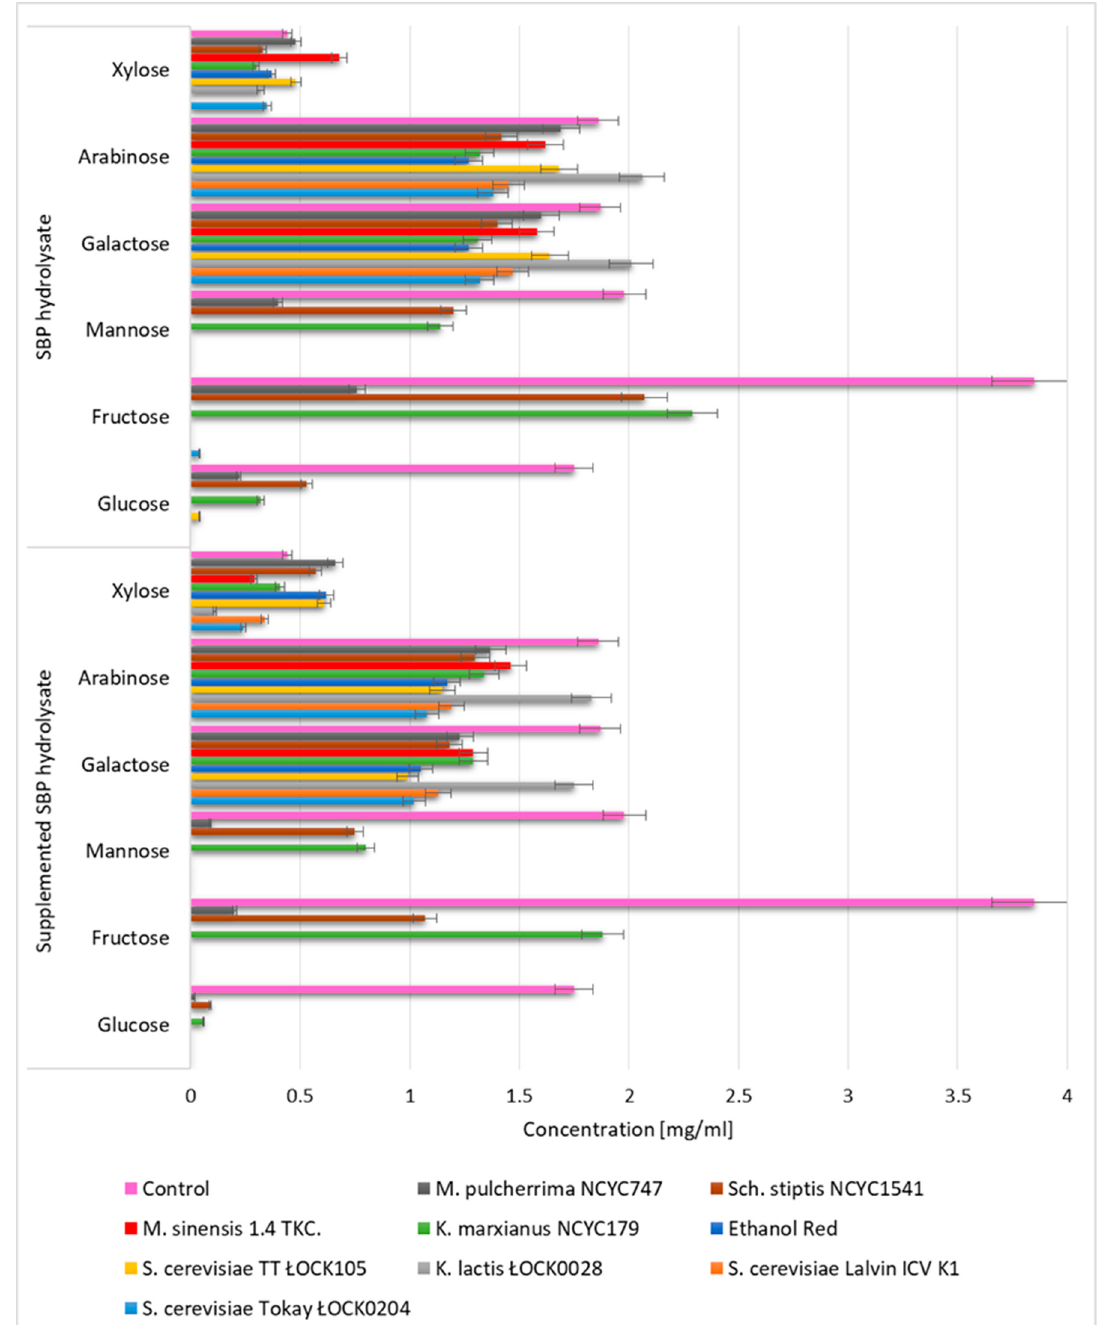
Figure 2 . Monosaccharide utilization by different yeast species cultivated in SBP hydrolysate. The data represent Figure 2. Monosaccharide utilization by di ff erent yeast species cultivated in SBP hydrolysate. The data means from three replicates in one experiment. Error bars denote SD. represent means from three replicates in one experiment. Error bars denote